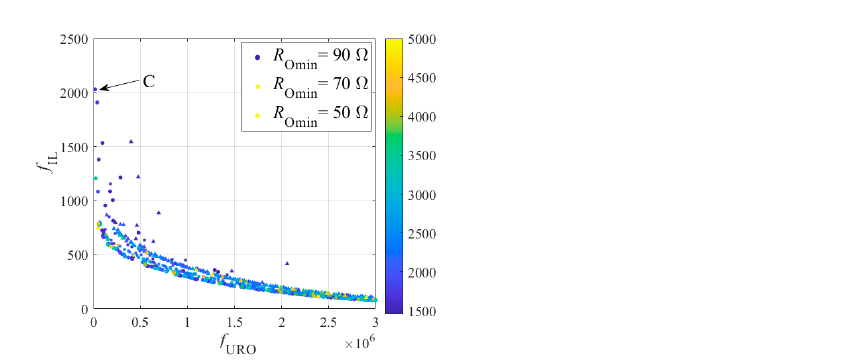
Figure 8. Pareto solutions with different range loads for CVO-type IPT system.